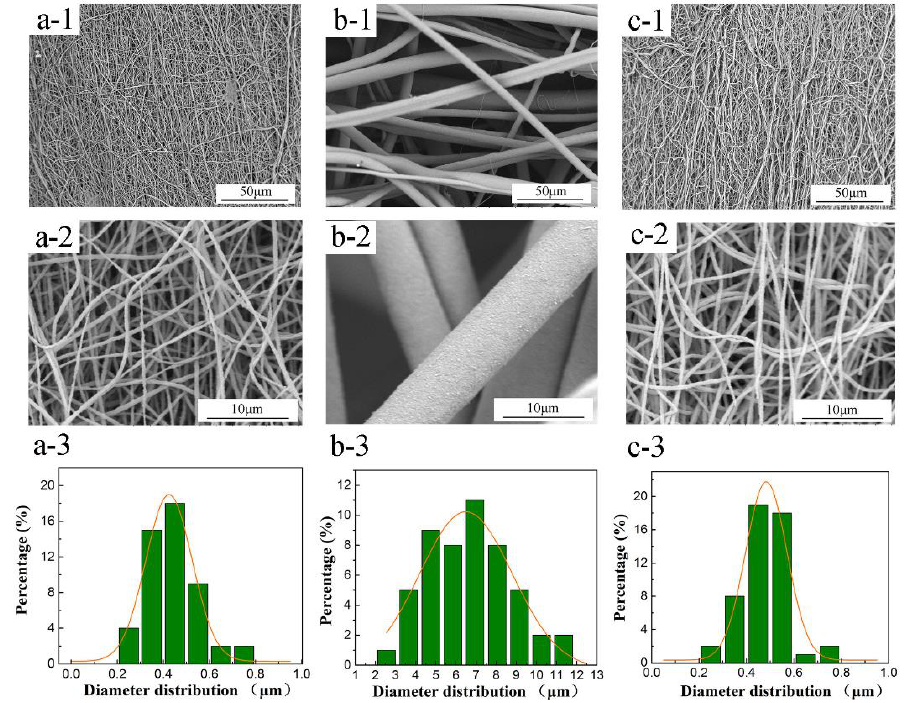
Figure 2. SEM images and the corresponding histograms of fiber diameter distribution of the nascent PTFE/PVA hollow fiber membranes. ( a ) The nascent M-1 membrane; ( b ) the nascent M-2 membrane; ( c ) the nascent M-3 membrane; (1) surface × 800; (2) surface × 5000; (3) fiber diameter distribution.